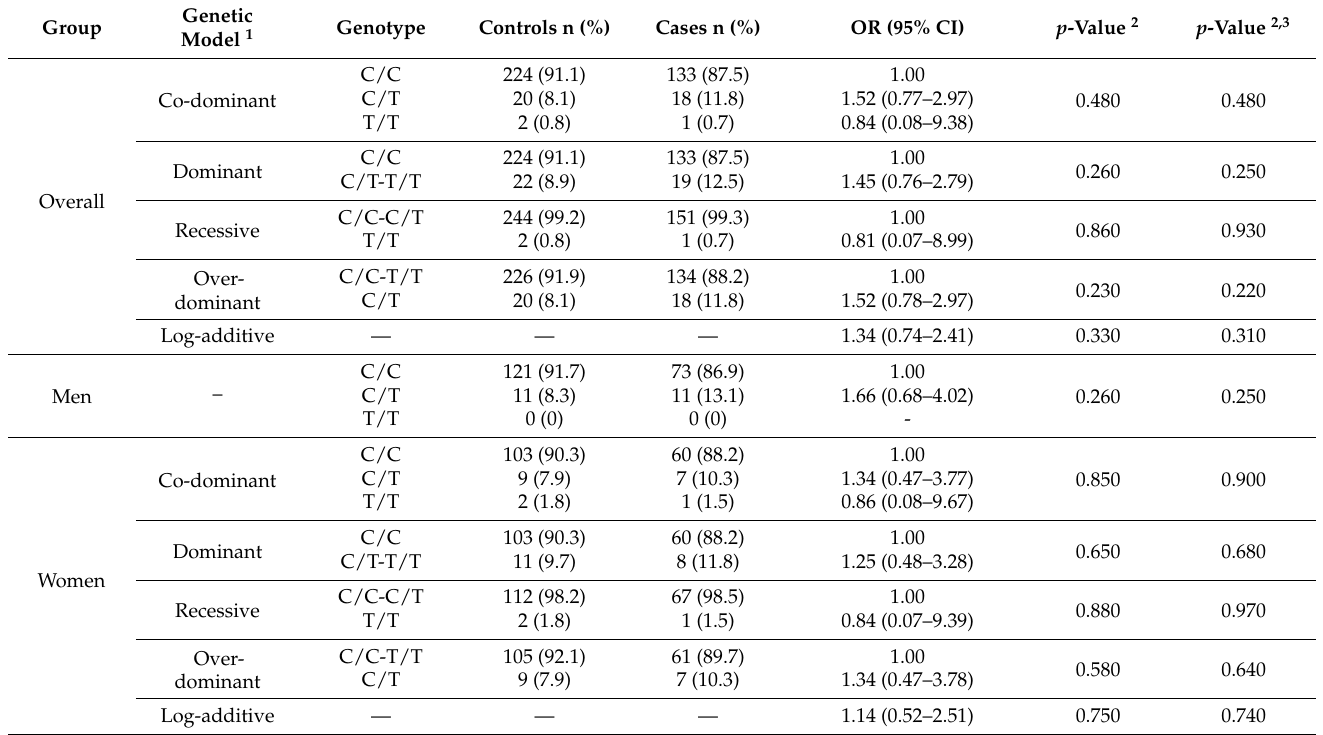
Table 3. Association analysis of rs7636836 polymorphism in FNDC3B with primary open-angle glaucoma.